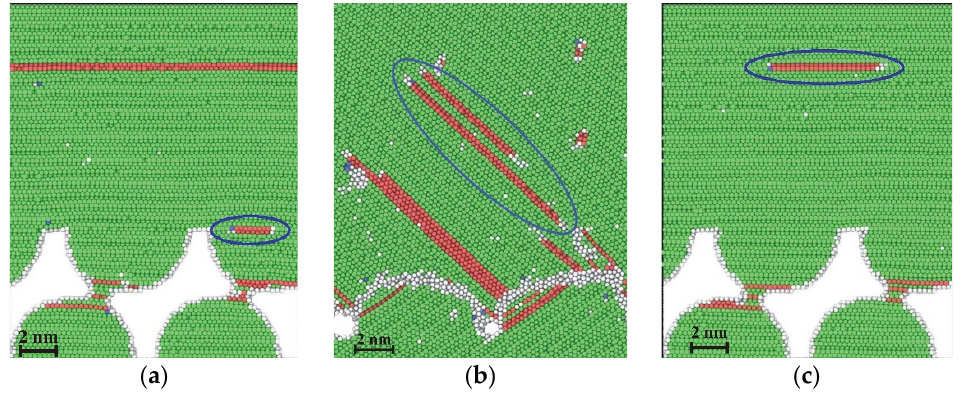
Figure 3. Typical snapshots of the atomic structure under the applied clamping pressure of 270 MPa indicating the nucleation of partial dislocations during USW: ( a ) emission of leading and trailing partials from the surface of a pore (Model I); ( b ) emission of leading and trailing partials from the interface formed as a result of joining of two crystalline blocks (Model II); ( c ) homogeneous nucleation of a dipole of partial dislocations in the bulk of the upper block (Model I). In the figures, emitted leading and trailing partials and the stacking fault between them are circled in blue. Atoms are colored according to their local crystalline structure (see description in text). Only parts of the computational cells are displayed.